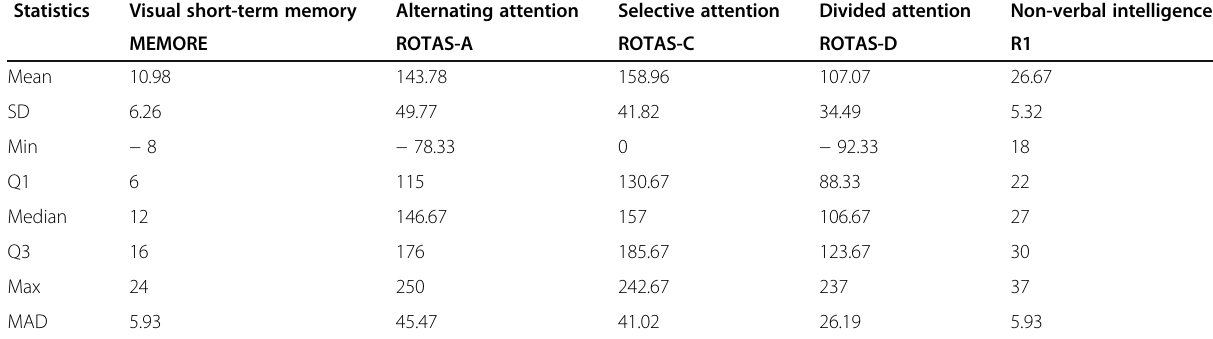
Table 2 Means, standard deviations, and other descriptive statistics of raw scores for all instruments Statistics Visual short-term